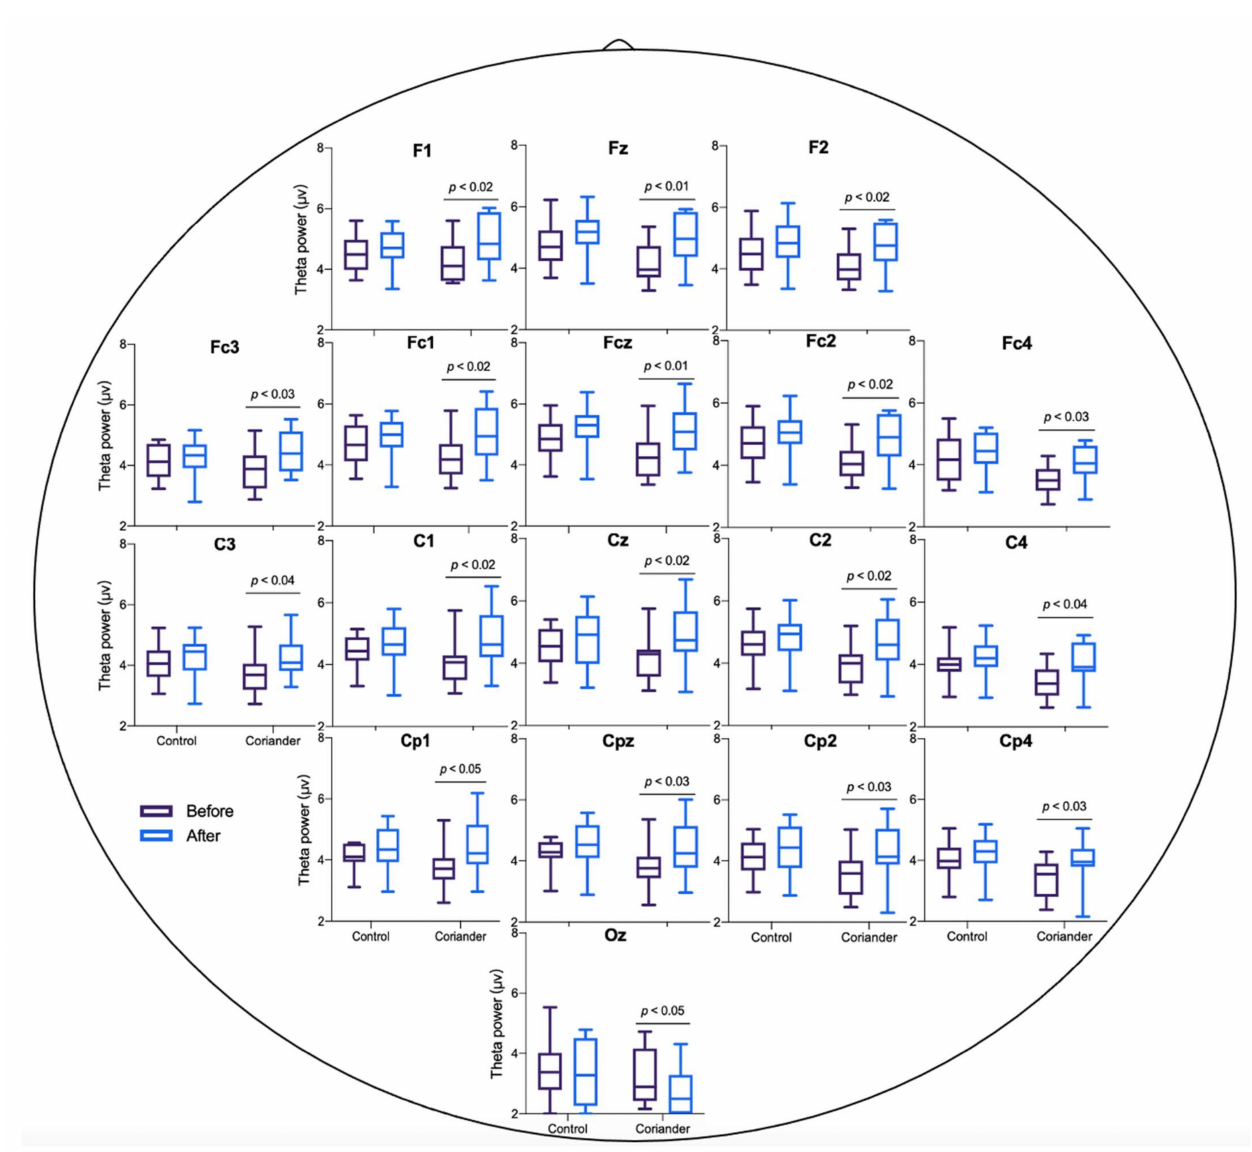
Figure 3. Theta wave power before and after homework in the group of coriander and control. The mean power in theta waves during the sit still for 5 min. Data presented as variation ± standard error ( n = 10). Paired t -tests were used to identify the significant differences before and after in the same